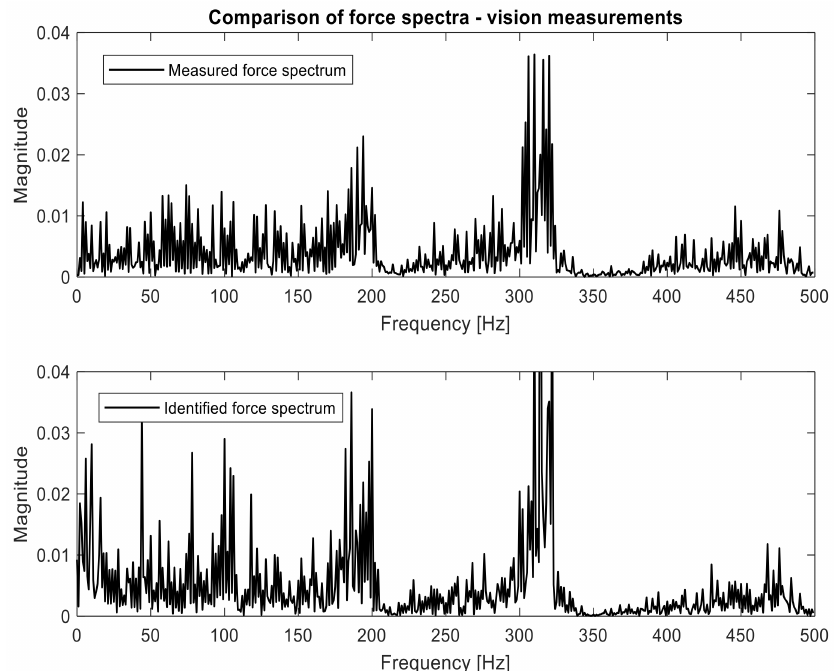
Figure 11. Comparison of measured and identified force spectra for the camera measurements (10 points—entire frequency range).